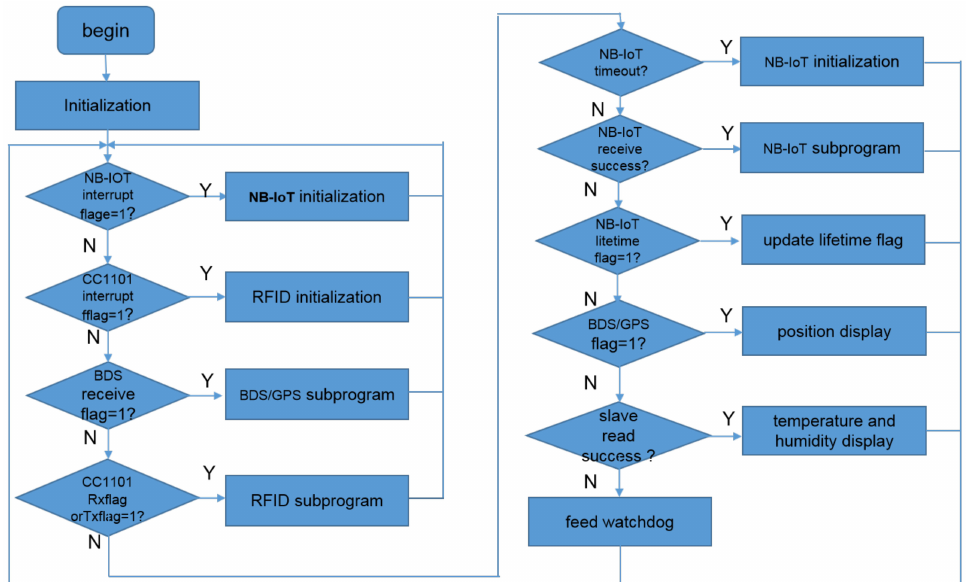
Figure 4. Main program flow chart of sink node.